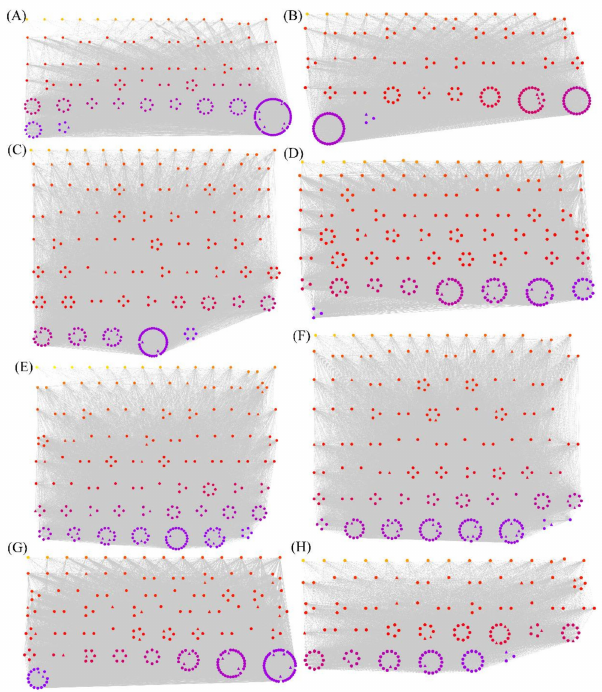
Figure 3. Visualization of the eight co-expression networks by Cytoscape. ( A ) the red, ( B ) black, ( C ) blue, ( D ) brown, ( E ) yellow, ( F ) turquoise, ( G ) green, and ( H ) pink modules, respectively. The most and least highly connected genes are shown in purple and yellow, respectively. The TFs are indicated by triangles, whereas the remaining genes are indicated by